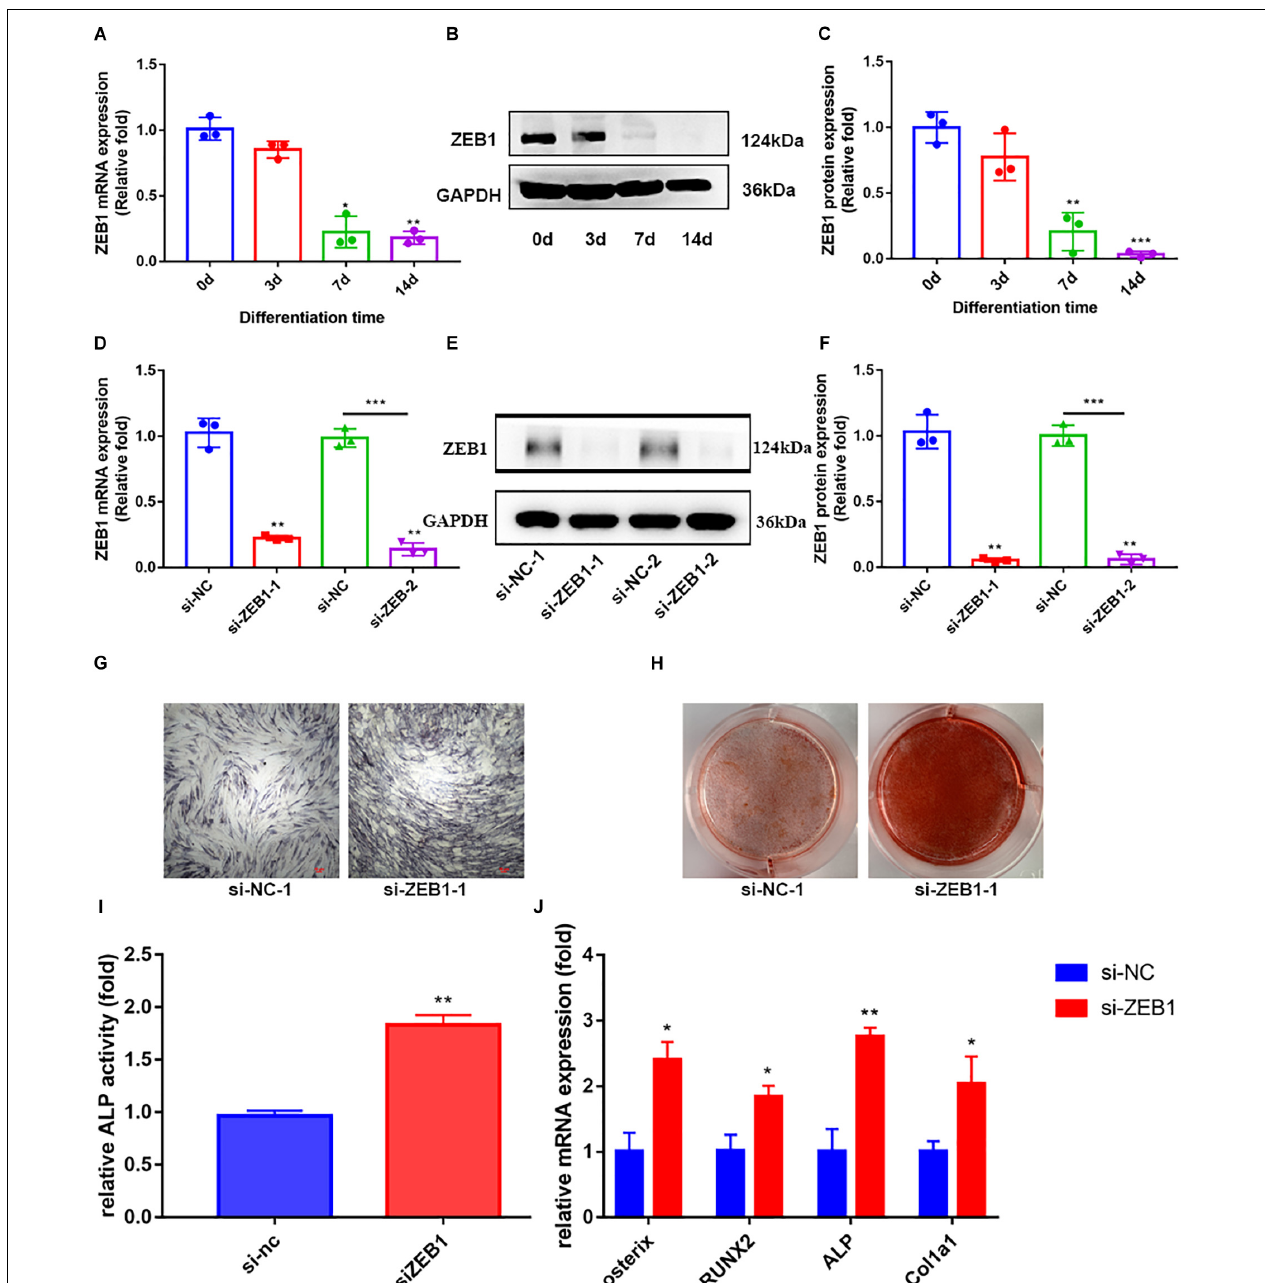
FIGURE 2 | Zinc finger E-box-binding homebox 1 (ZEB1) knockdown enhanced the osteogenesis of hBMSCs. (A) qRT-PCR analysis demonstrated that the mRNA expression of ZEB1 decreased after osteogenic differentiation. (B,C) Western blotting analysis showed that the protein expression of ZEB1 decreased after osteogenic differentiation. (D) ZEB1 expression decreased after siZEB1 treatment – evaluated by qRT-PCR. (E,F) ZEB1 expression decreased after siZEB1 treatment – evaluated by western blotting. (G,H) ALP staining and alizarin red staining of hBMSCs after transfecting with siZEB1. (I) ALP activity of hBMSCs after transfection with siZEB1. (J) qRT-PCR analysis demonstrated that siZEB1 transfection increased the mRNA level of ALP, osterix, RUNX2, and Col1a1. * p -value < 0.05, ** p -value < 0.01 and *** p -value <